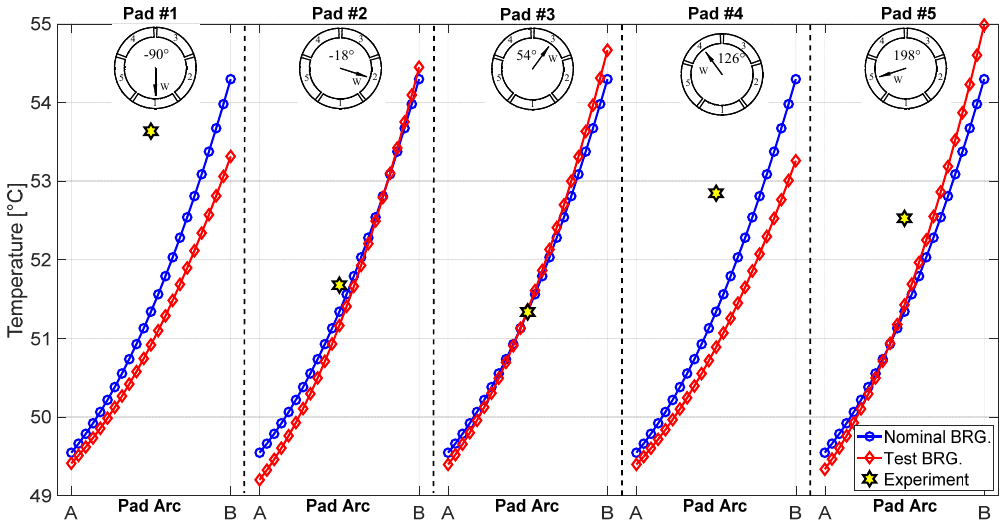
Figure 15. Predicted oil film temperatures along the center line of the loaded pad and measured pad temperatures. Positions A and B present the leading and trailing edge of the loaded pad, respectively.